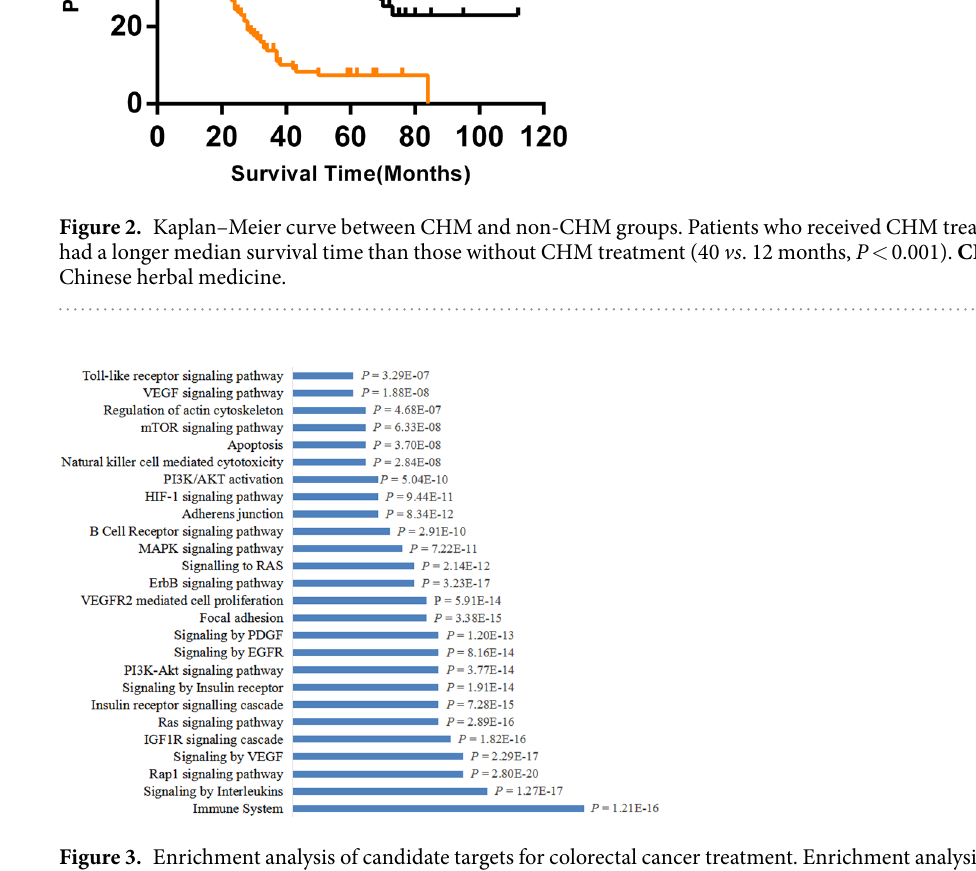
Figure 3. Enrichment analysis of candidate targets for colorectal cancer treatment. Enrichment analysis showed that candidate targets for colorectal cancer treatment were frequently involved in intracellular signaling cascades and immune